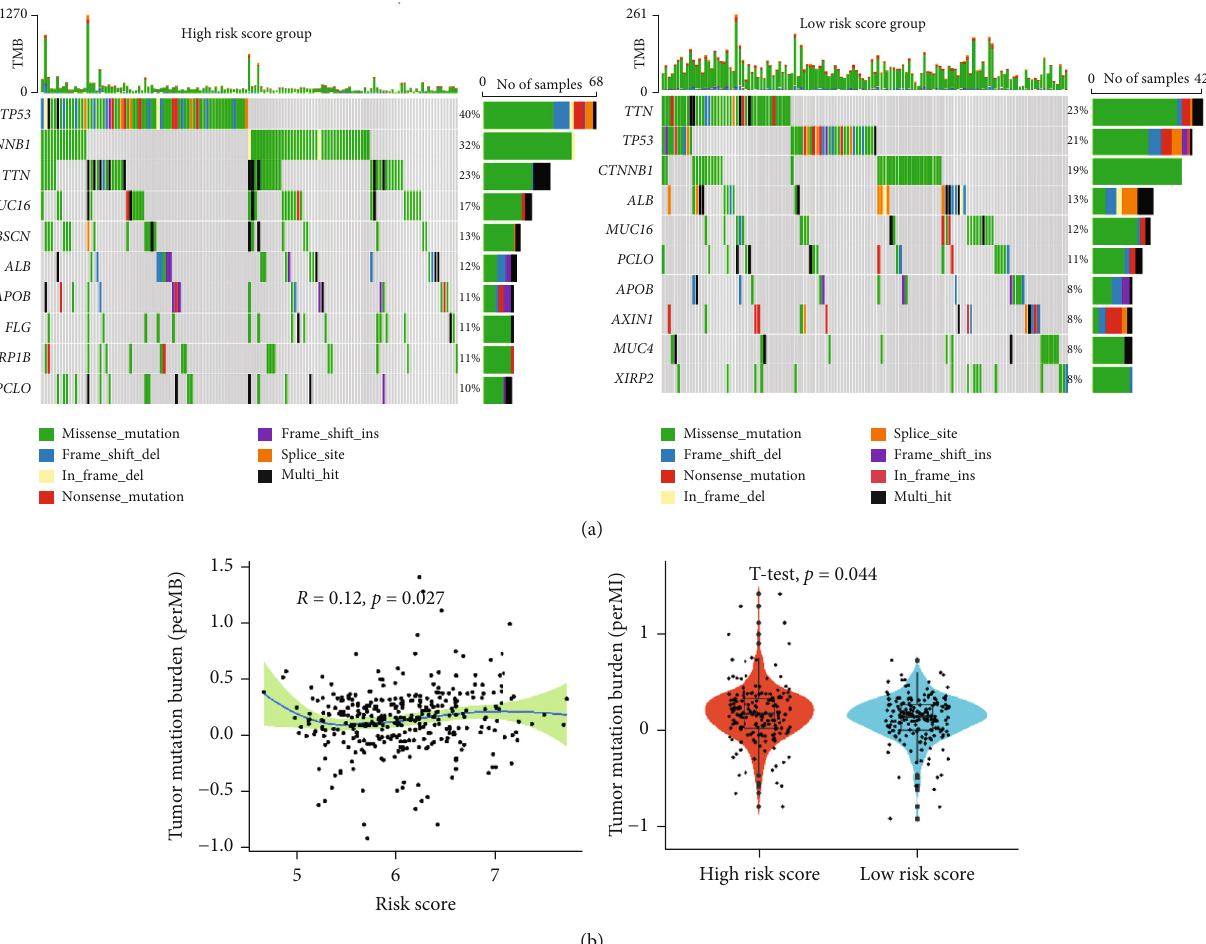
Figure 5: Genetic mutation and TMB analysis. (a) Tumor maps of mutated genes in two subgroups. (b) Correlation and di ff erential analysis of risk scores and